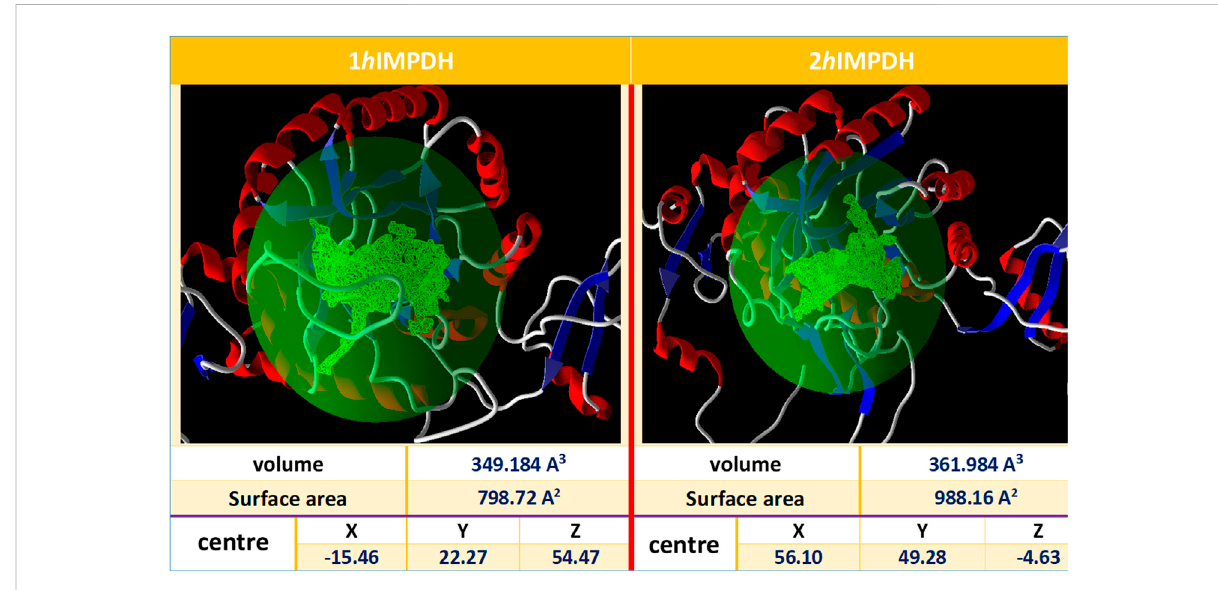
FIGURE 1 Overview of the selected cavities in both isoforms along with their characteristics.